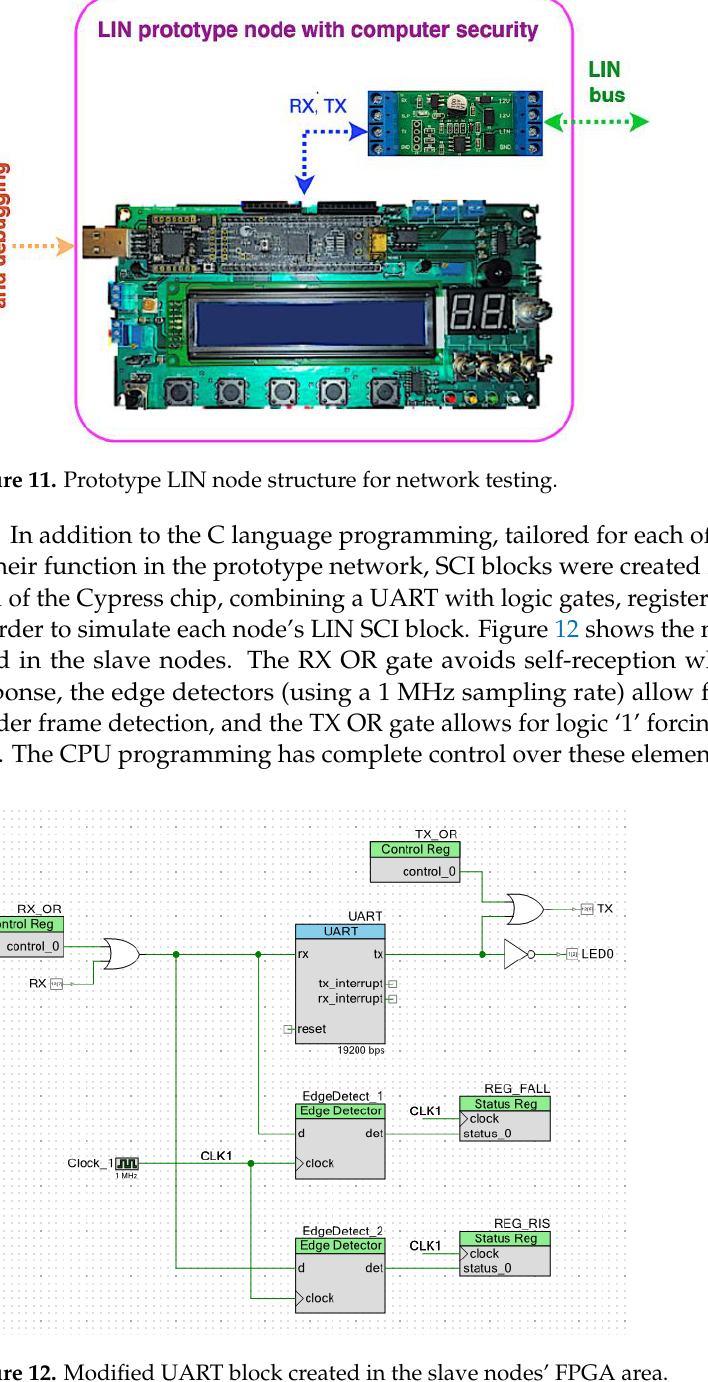
Figure 10. Prototype LIN node composed of a ( a ) development board and ( b ) LIN transceiver.